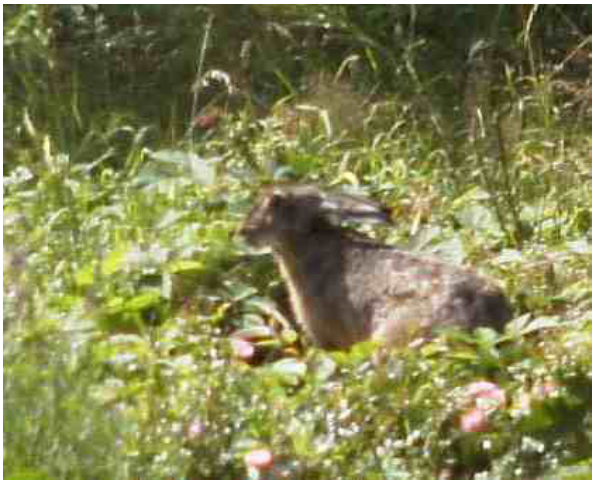
Figure 30. Wildlife inside of the sheltered station